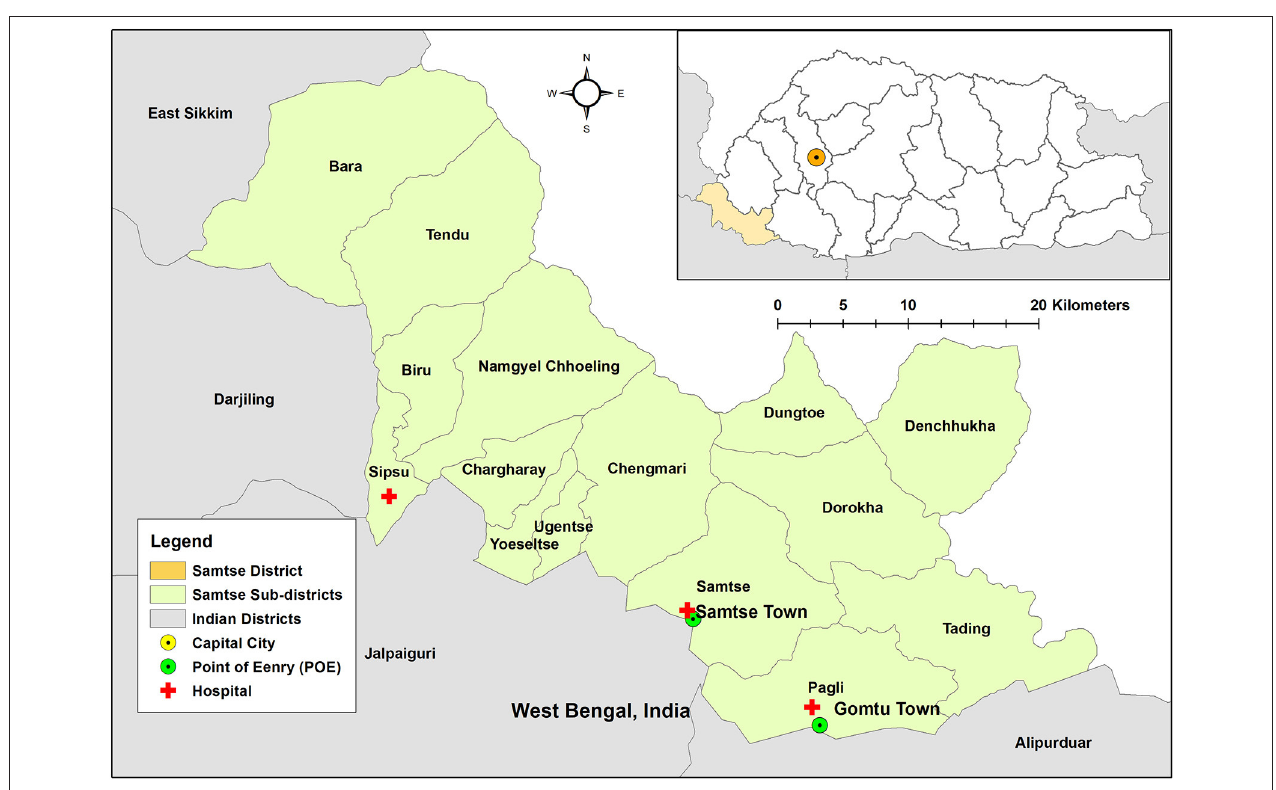
FIGURE 1 | Samtse District (study area) and its location, Bhutan.